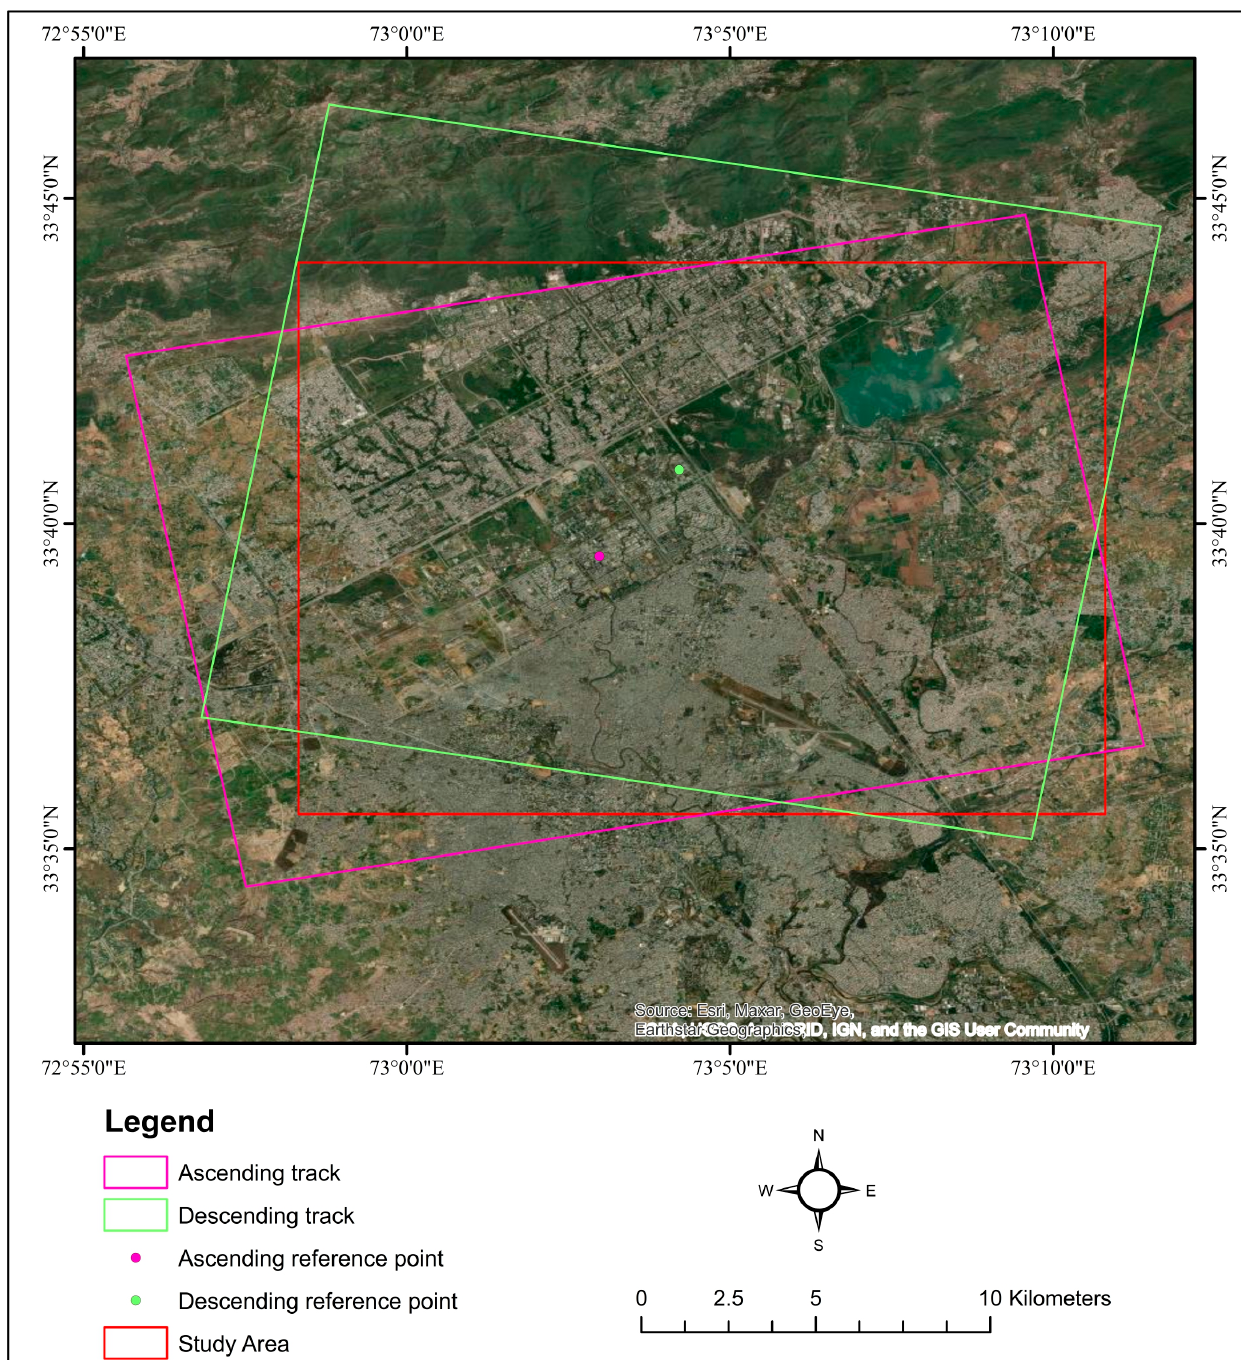
Figure 2. Examined area (in red) with footprints, reference points, and the master area (ascending and descending). and